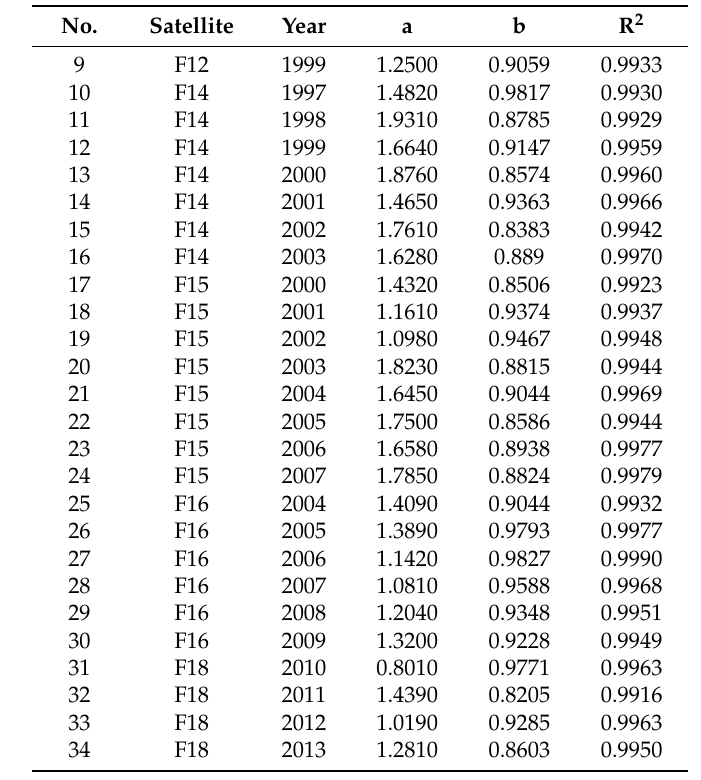
Table A2. Coefficients of the quadratic polynomials for partitioning images from 1992 to